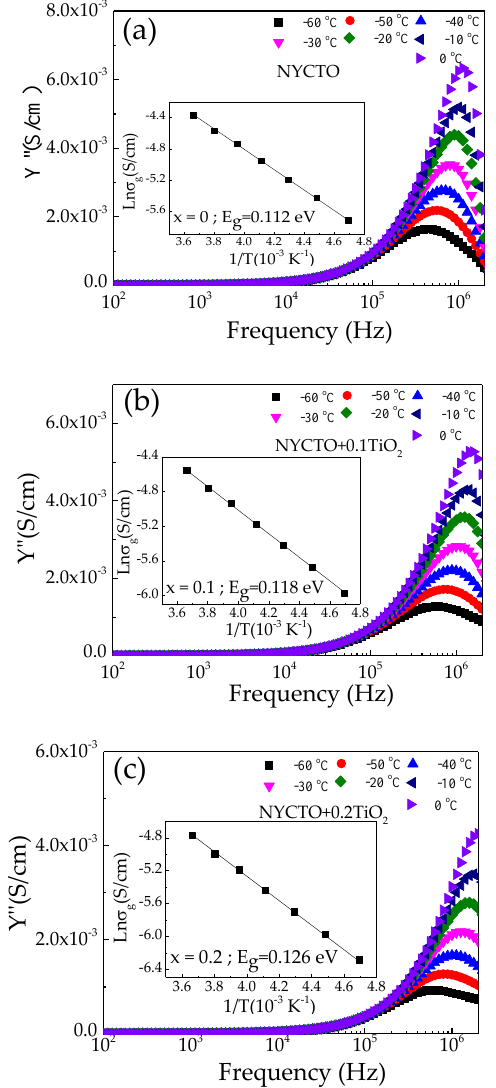
Figure 10. Imaginary part of admittance (Y”) as a function of frequency at different temperatures ( − 60 – 0 °C) for NYCTO + xTiO 2 ceramics with x = ( a ) 0.0, ( b ) 0.1 and ( c ) 0.2; their insets show the Arrhenius plots for the grain conductivity ( σ g ).